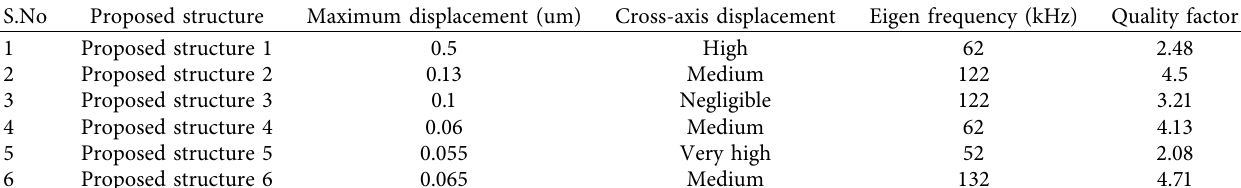
Table 1: Comparison of six proposed